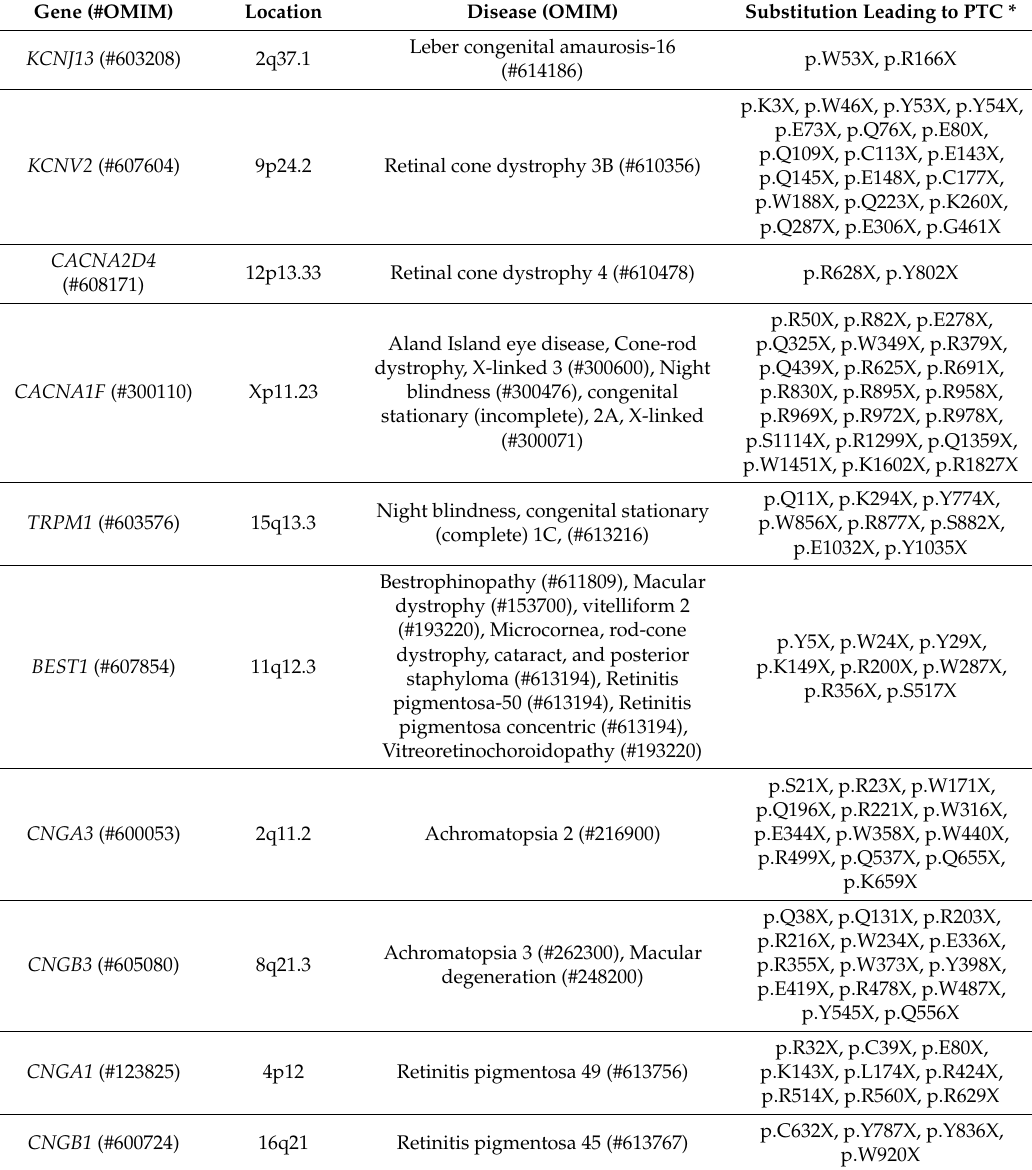
Table 1. Nonsense mutations in the eye and resulting